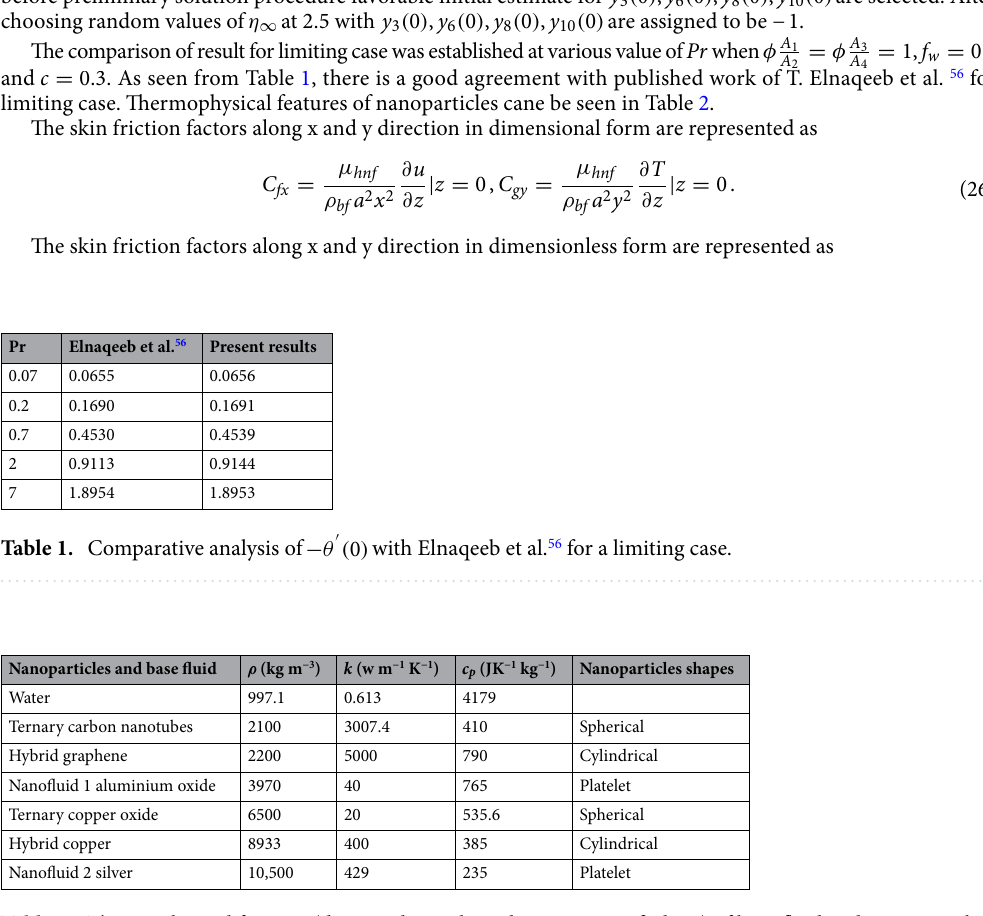
Table 2. Thermophysical features (density, thermal conductivity, specific heat) of base fluid and nanoparticles.